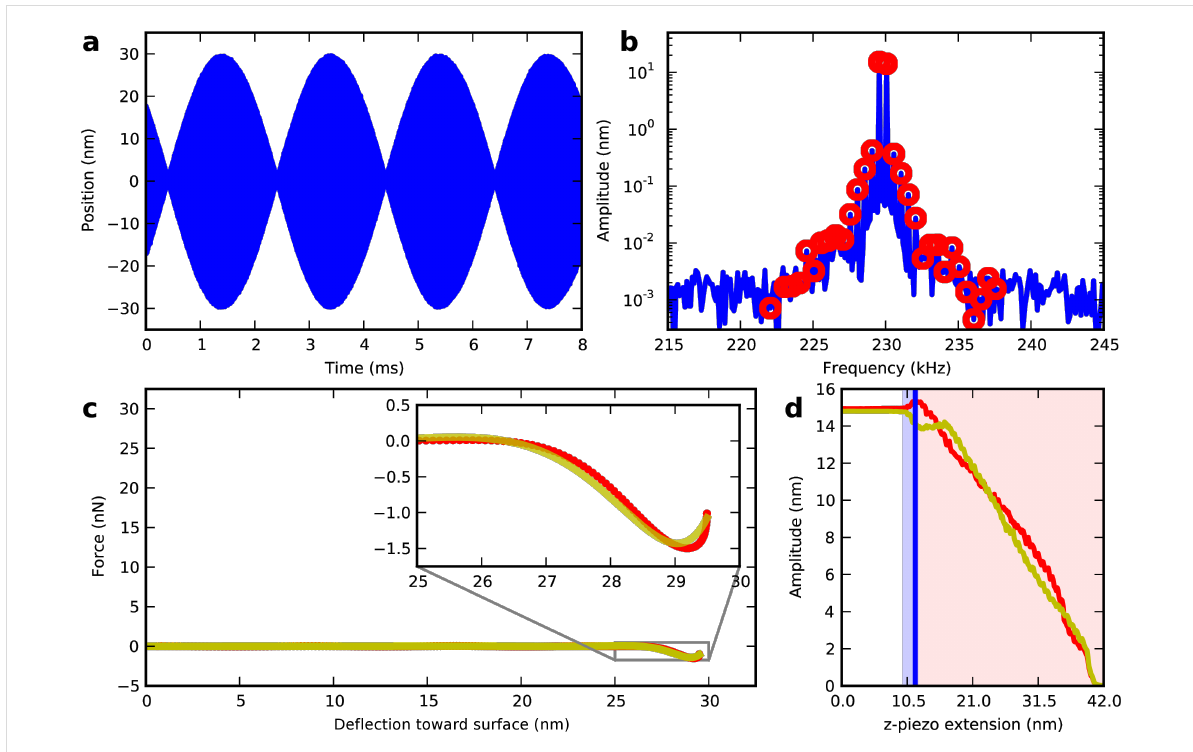
Figure 2: One frame from a surface-approach movie (see Supporting Information File 1) showing the very onset of repulsive forces. The beating waveform (a) has the intermodulation spectrum around resonance (b) where the red circles are analyzed to reconstruct the tip–surface force (c) using both polynomial (yellow) and ADFS (red) methods. The z-piezo extension z piezo = 11.8 nm is indicated by the blue vertical line in (d) which displays the amplitudes at the two drive frequencies. The interaction is purely attractive in the blue shaded area, becoming repulsive in the red shaded